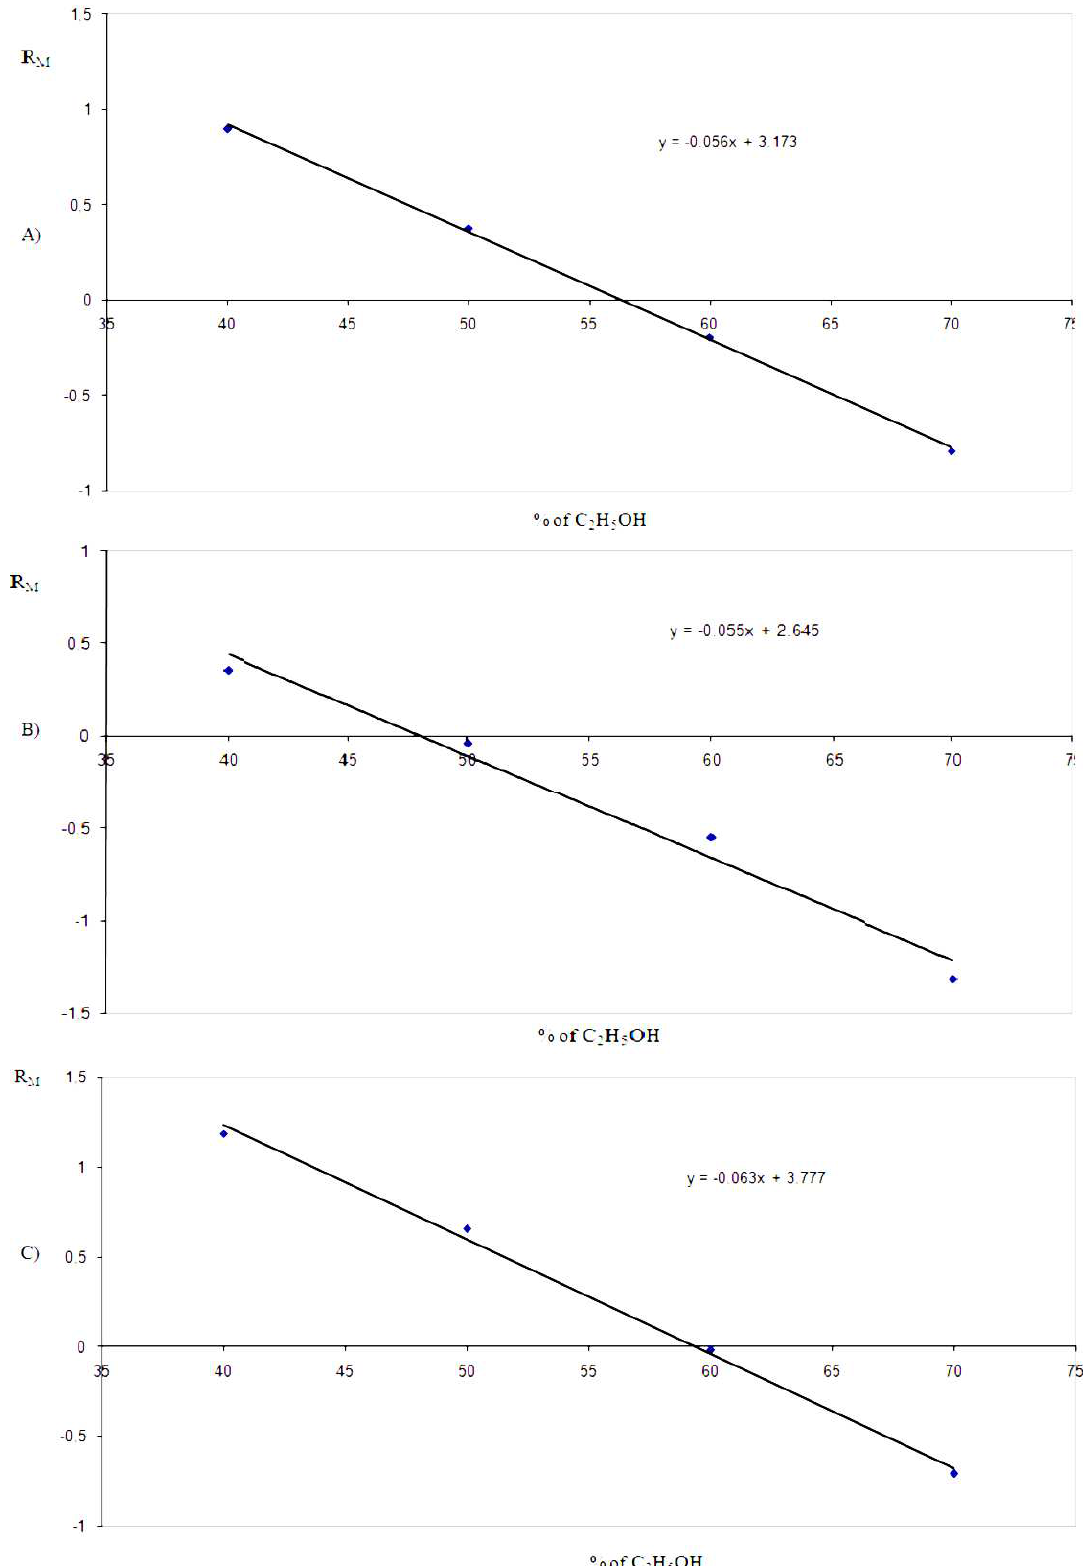
values versus the ethanol content; A) FA, B) CFA and C) Figure 3. R M